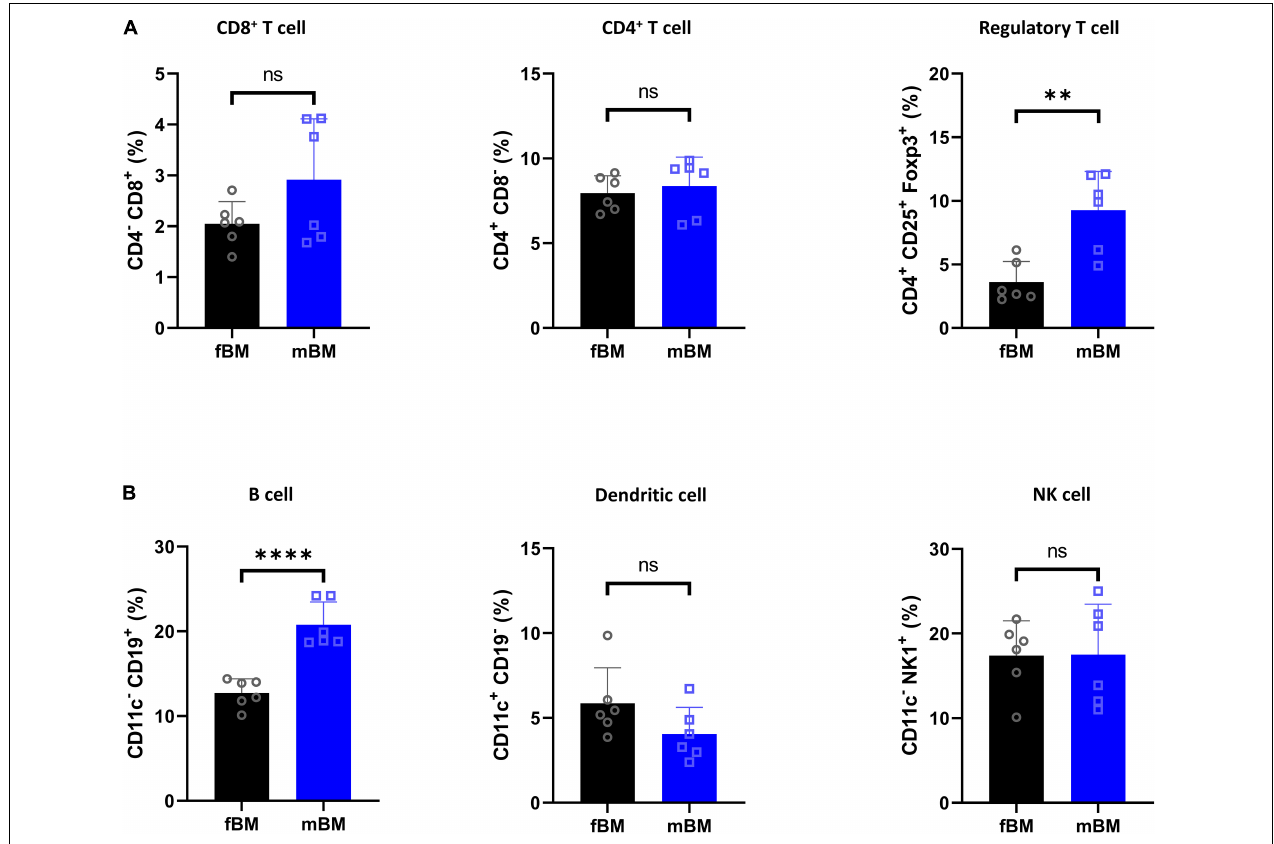
FIGURE 3 | Regulatory T cell and B cells are present in higher proportions in mandibular bone. (A) Flow cytometry of T cell subpopulation from fBM and mBM. (B) Percentage of B cell, dendritic cell and NK cell from fBM and mBM. Unpaired t test; data are presented as mean ± SEM of value from four independent experiments consisting fBM and mBM, ∗∗ P < 0.01, ∗∗∗∗ P <